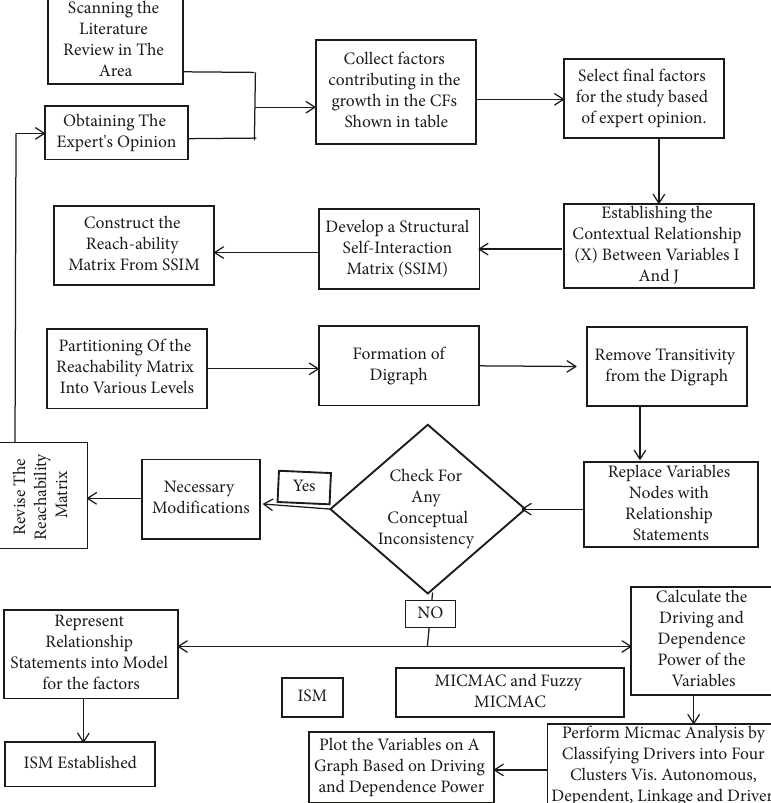
Figure 1: Flow diagram for preparing the ISM